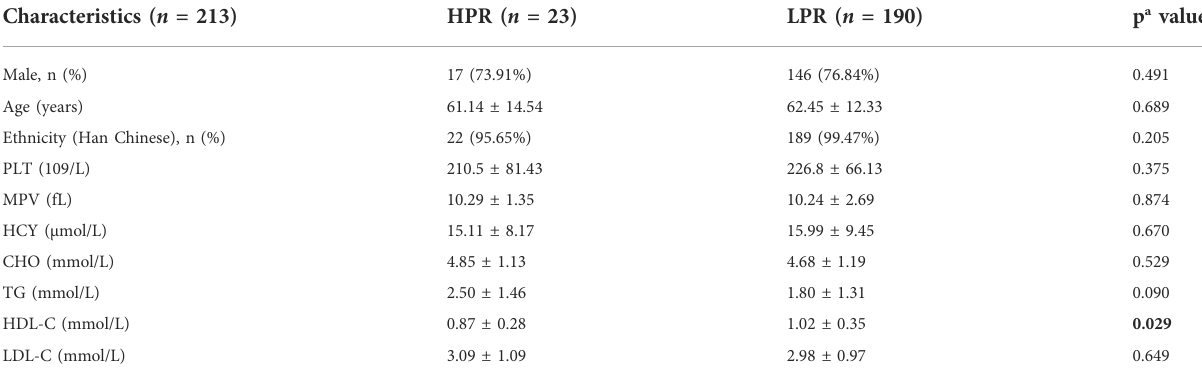
TABLE 1 Demographic characteristics of